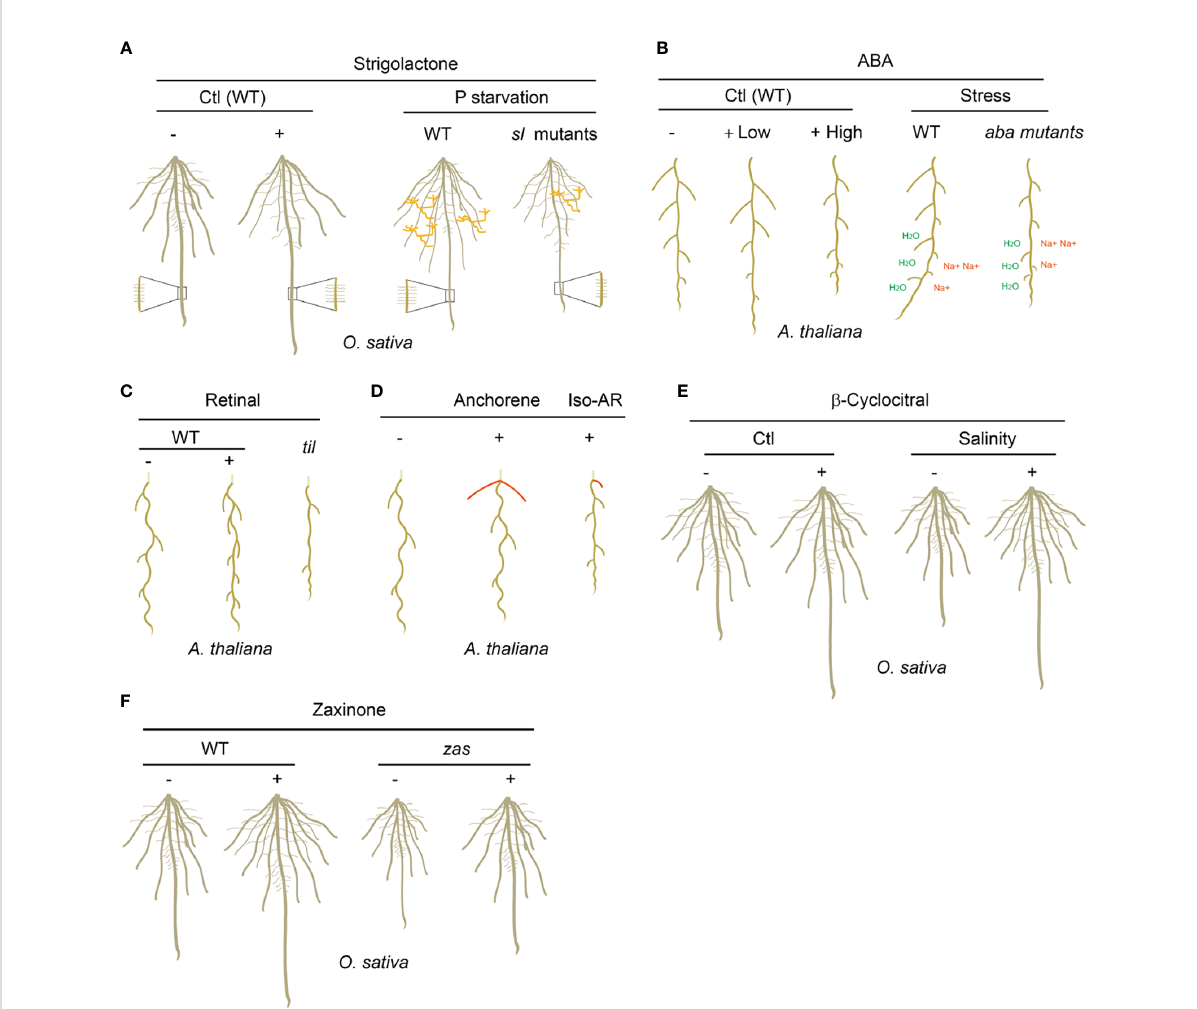
FIGURE 2 The biological functions of carotenoid-derived metabolites on plant root development and adaption to rhizospheric environments. (A) SLs enhance the length of the primary root, seminal roots and root hairs, but inhibit lateral root density in rice under normal growth condition; under P starvation growth condition, wild type (WT) rice plants grow longer seminal roots and root hairs, and less lateral roots, which is not observed in SL biosynthesis and signaling mutants ( sl mutants); WT rice plants establish more arbuscular mycorrhizal symbiosis than sl mutants under P starvation. AMF are marked as orange. (B) Low concentrations of ABA promote the length of primary root and lateral roots, while high concentrations of ABA inhibit them; under drought and salinity soil growth conditions, the WT but not the ABA biosynthesis and signaling mutants ( aba mutants) plants possess hydrotropism and negative halotropism manners to grow toward higher water potentials and escape from salty environment. “ H 2 O ” indicates higher water potentials and “ Na + ” indicates higher salt concentrations. (C) Retinal determines the spatial distribution of lateral root prebranch sites in a periodic oscillation transcriptional mechanism in Arabidopsis; til mutant has signi fi cantly decreased-lateral root capacity and -root clock amplitude due to the decreased sensitivity to retinal. (D) Anchorene promotes the formation of anchor roots, while iso-anchorene (iso-AR) mainly inhibits the growth of primary root. Anchor roots are marked as red and the partial hypocotyl is marked as light green. (E) b -Cyclocitral enhances primary root growth and lateral root branching by promoting root stem cell divisions; under salinity growth condition, exogenous applied b -cyclocitral could promote the root growth and therefore increase the tolerance to salt stress. (F) Zaxinone promotes the root growth and enhances the root biomass in rice; the zas mutant displayed decreased root biomass which can be restored by zaxinone application. “ - ” indicates no treatment and “ + ” indicates exogenous carotenoid-derived metabolites treatments. “ Ctl ” indicates plants grow under normal